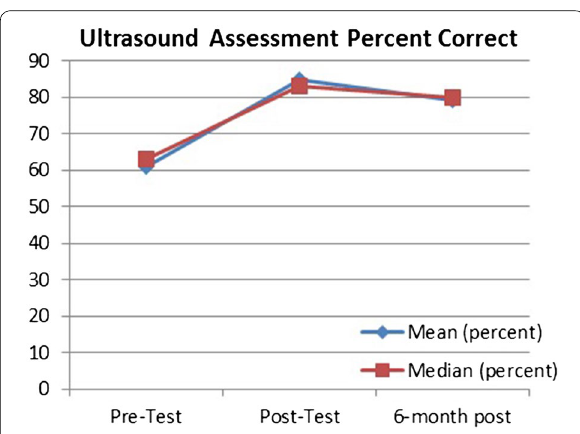
Fig. 5 Assessment percent correct—mean and